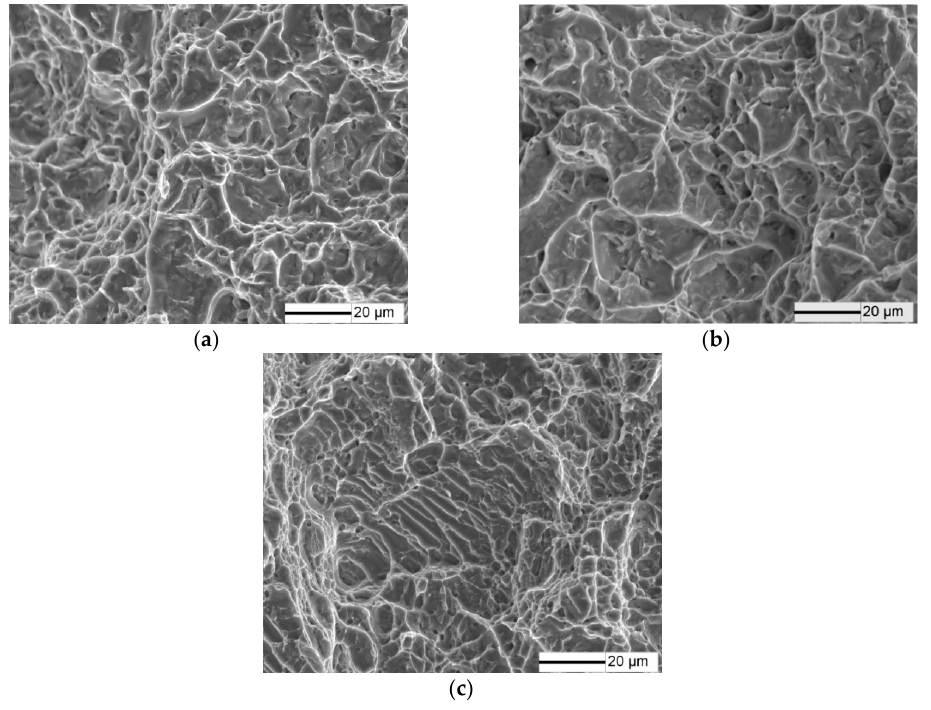
Figure 7. Fracture surface of ( a ) Ti64; ( b ) joints and ( c ) Ti17.